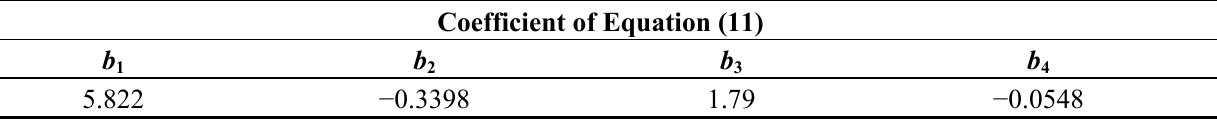
– b for computing parameter b . 1 4